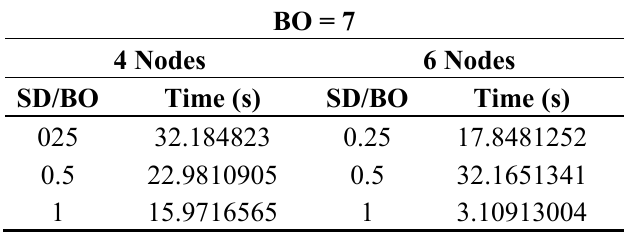
Table 8. Standard deviation of the set-up time samples. BO =